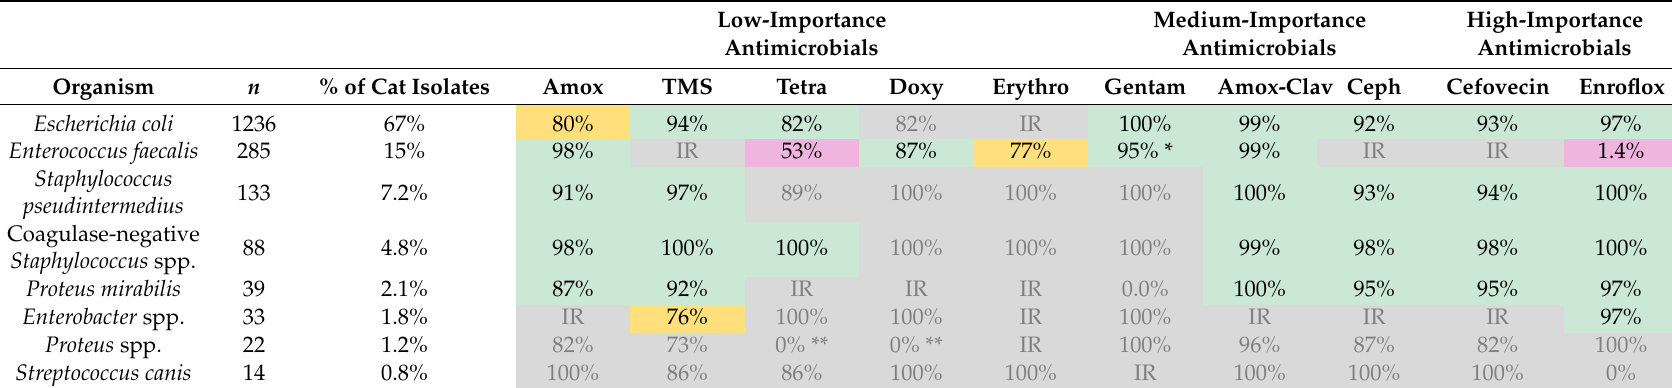
Table 3. Antimicrobial susceptibility and importance ratings for the most prevalent urinary isolates from cats. Amox: amoxicillin; TMS: trimethoprim-sulfonamide; Tetra: tetracycline; Doxy: doxycycline; Erythro: erythromycin; Gentam: Gentamicin; Amox-Clav: amoxicillin-clavulanate; Ceph: cephalexin; Enroflox: enrofloxacin. Low-Importance Medium-Importance High-Importance Antimicrobials Antimicrobials Antimicrobials n % of Cat